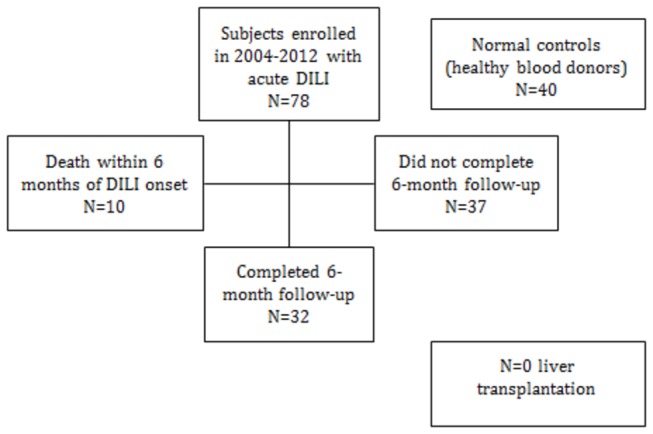
Flow diagram of study cohort.Sera from 78 DILI subjects and 40 healthy controls (volunteer blood donors) were analyzed in the study. Among those patients with acute DILI, 10 died within 6 months of DILI onset and 37 returned for a 6-month follow-up visit, among whom serum samples were obtained from 32.